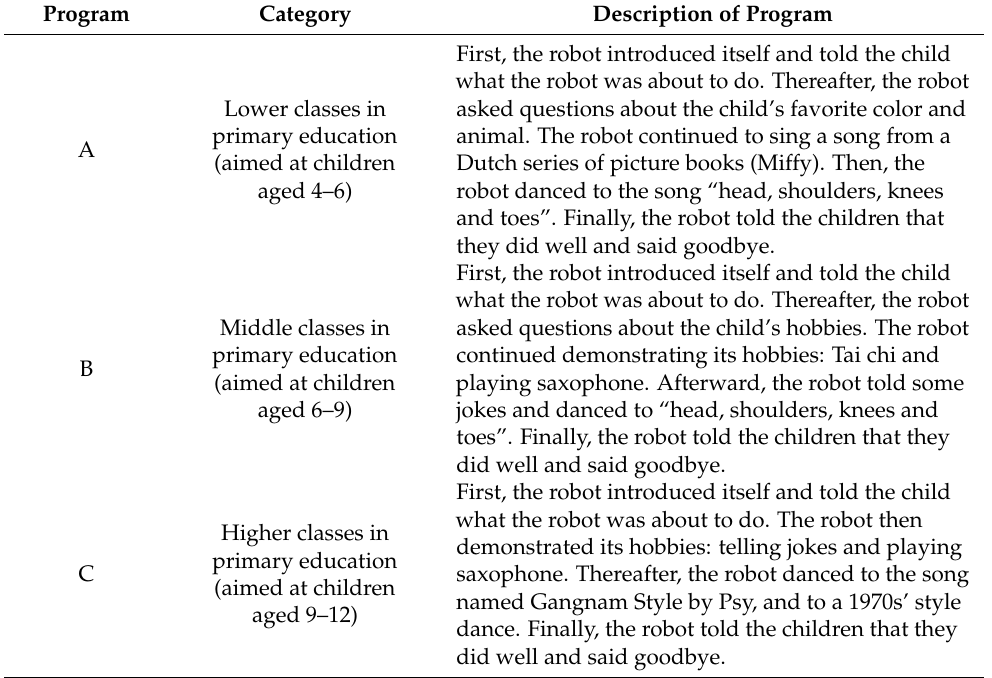
Table 1. Features of the robot programs used and their target